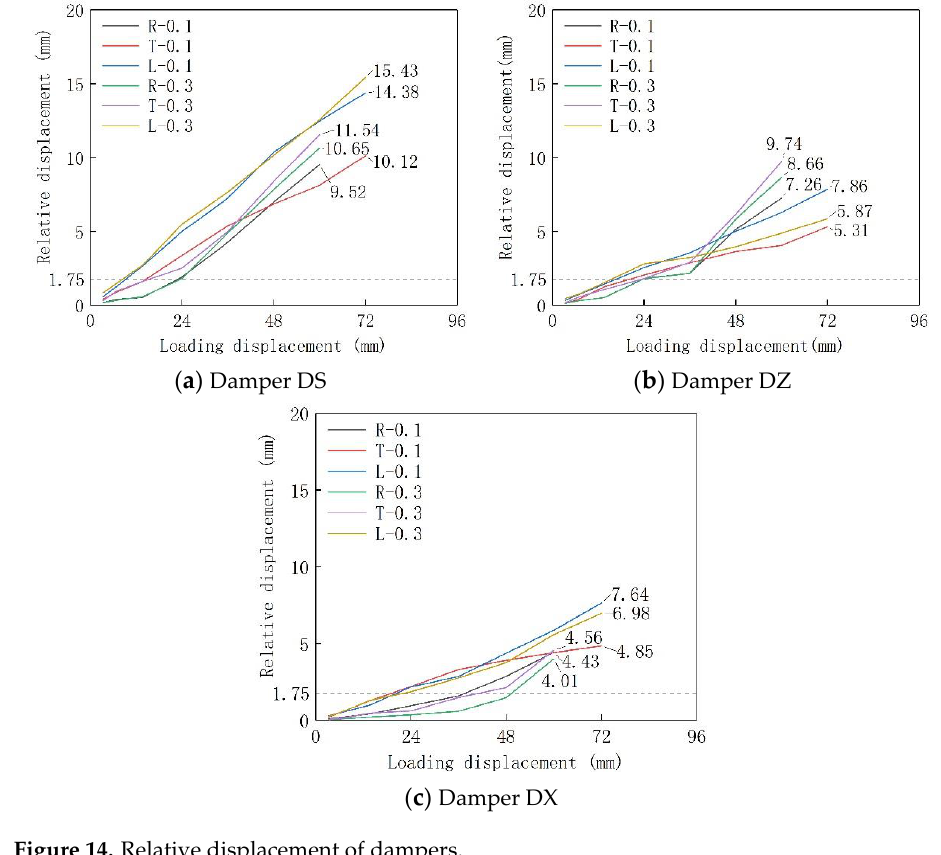
Figure 14. Relative displacement of dampers. Table 7. Relative displacement of damper DS.